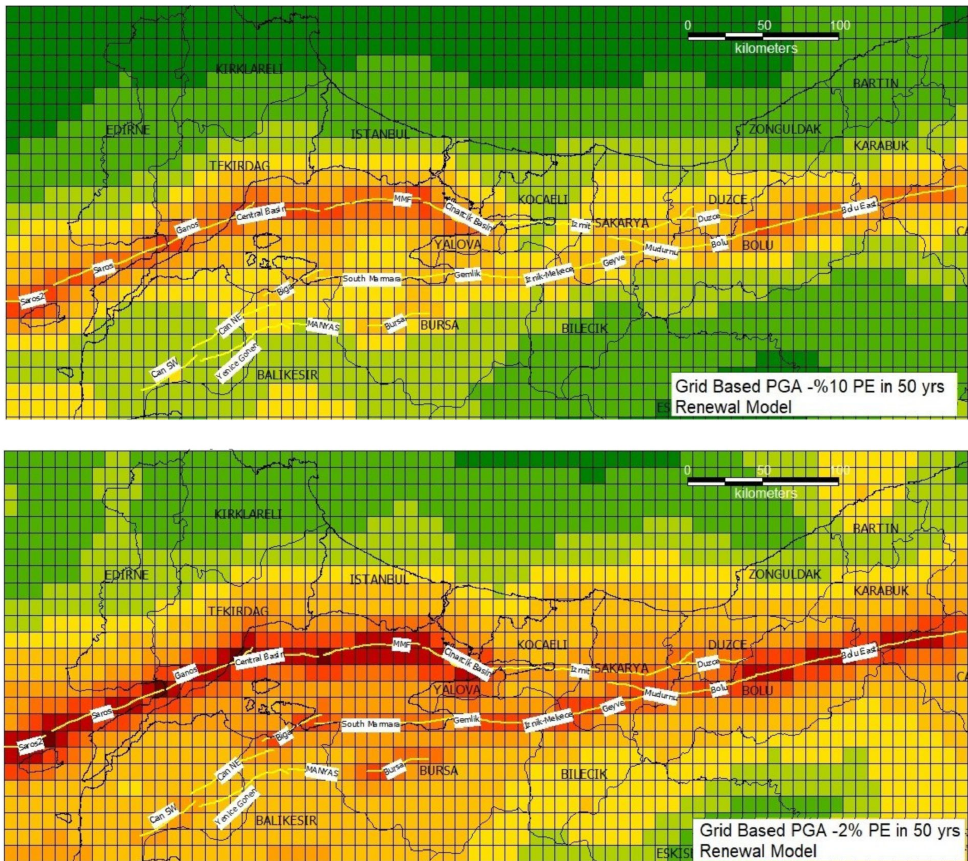
Figure 20. Grid-based PGA distribution at NEHRP B / C boundary site class for 10% (upper panel) and 2% (lower panel) probabilities of exceedance in 50 years (Renewal model). Color coding is the same as in Figure